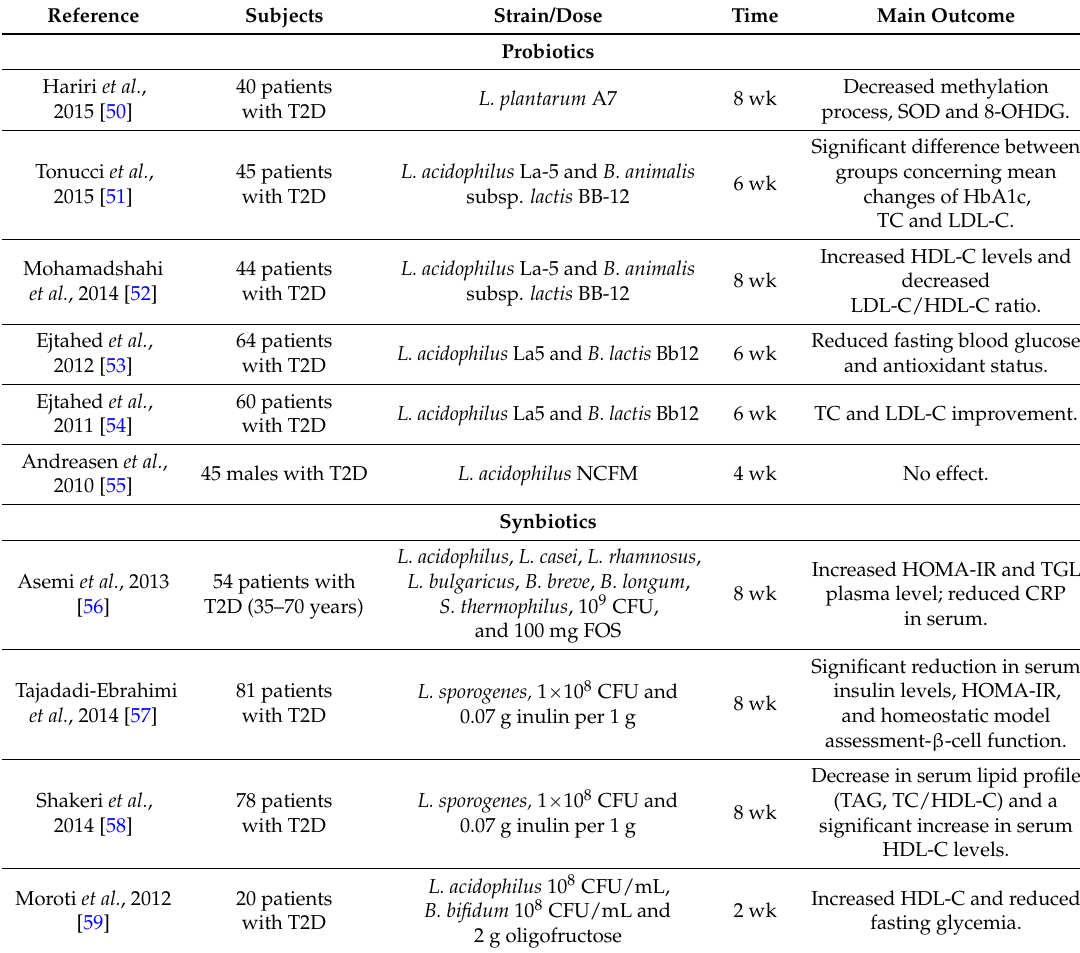
Table 3. Summary of randomized clinical intervention trials of probiotics and synbiotics in type 2